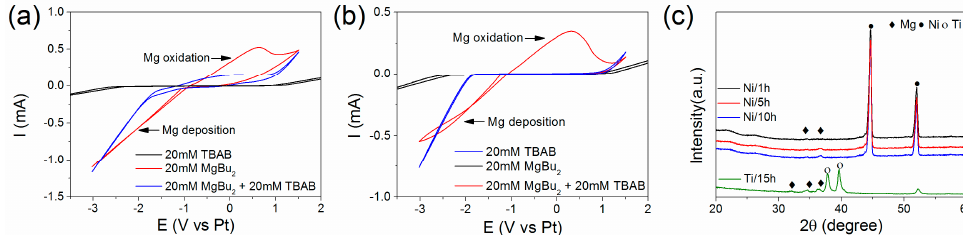
Figure 1. Cyclic voltammogram of di- n -butylmagnesium (MgBu 2 ) with and without tetrabutylammonium bromide (TBAB) at ( a ) the Ni foam electrode and ( b ) the Ti foil electrode;